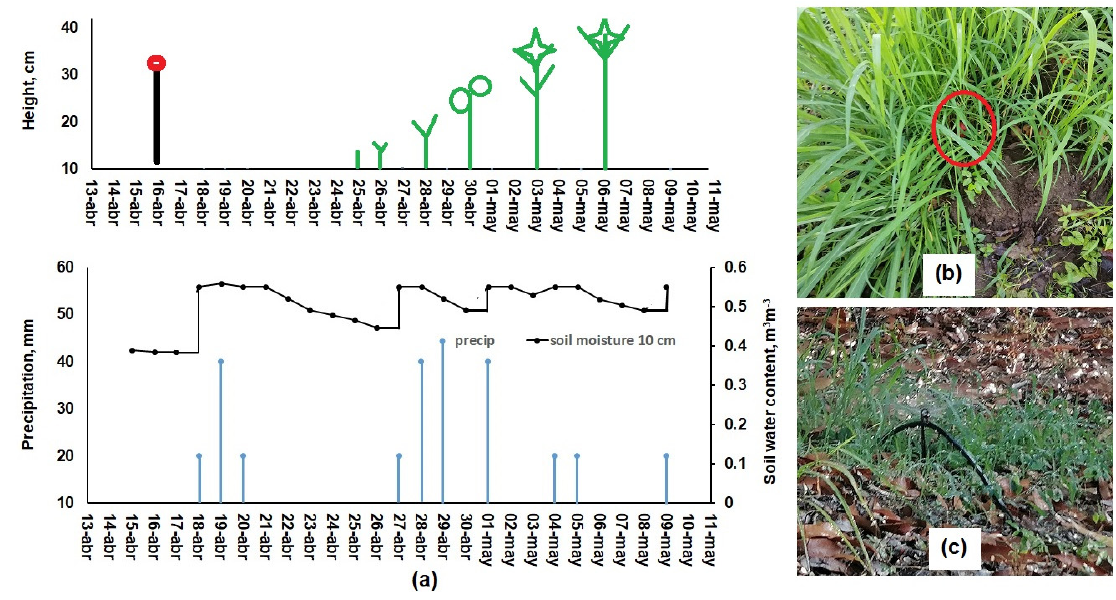
Figure 7. Water moisture ( a ) measured in the soil where weeds grow, ( b ) causing weeds to grow over a micro-sprinkler, and ( c ) soil with fine weeds.